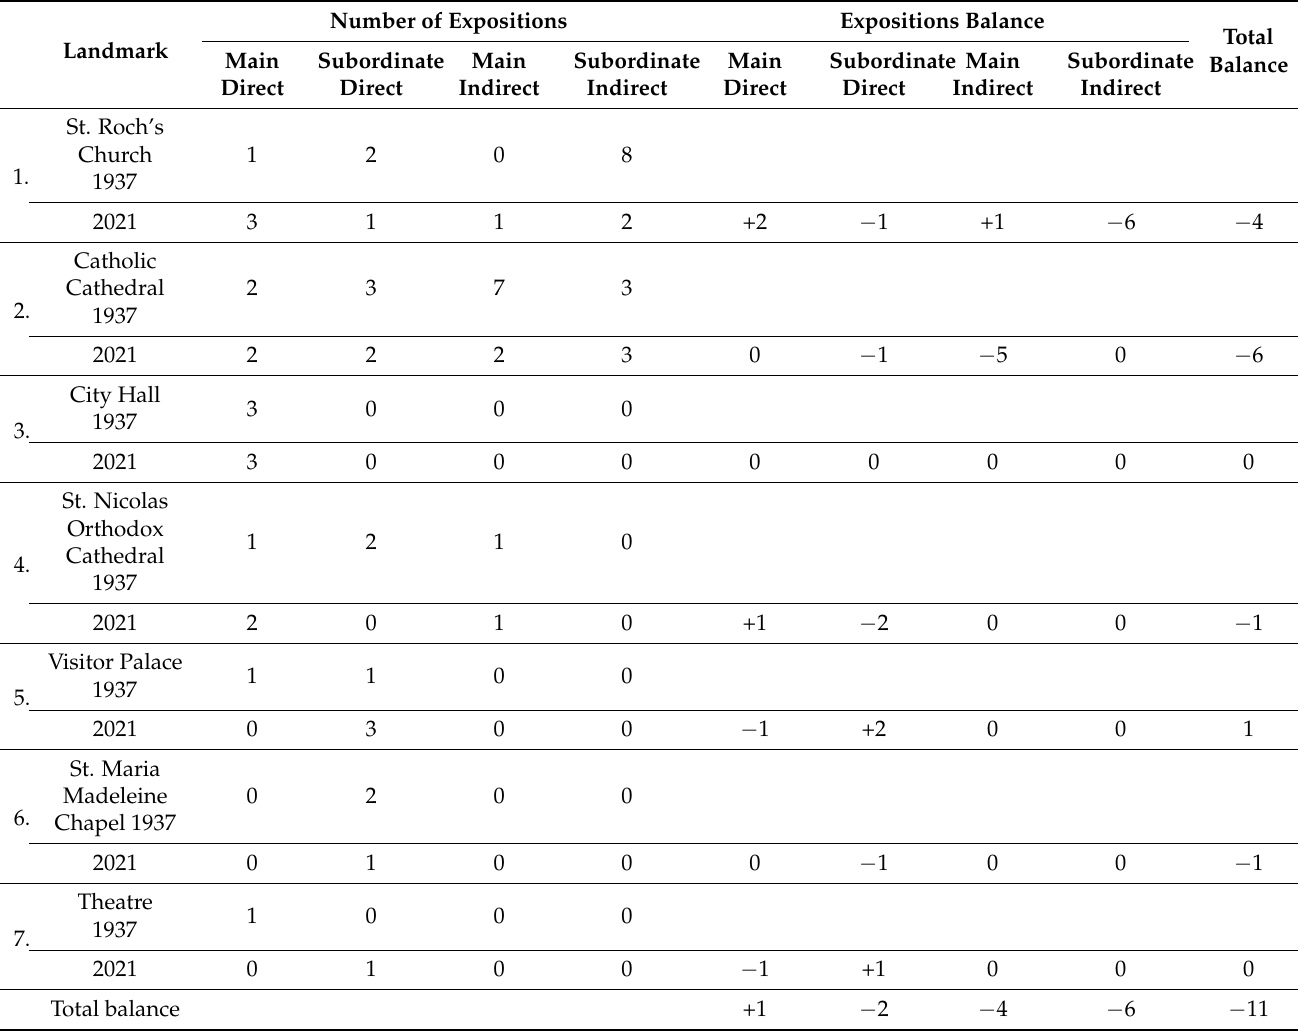
Table 1. Summary of changes in the number and rank, and the final balance of visual exposition directions of selected major landmarks in the research area; prepared by B. Czarnecki.